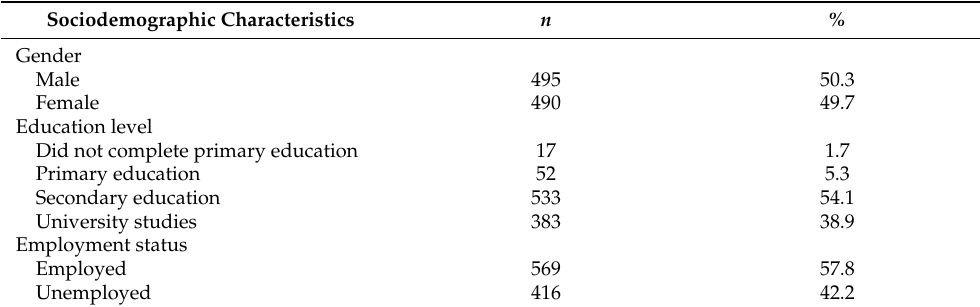
Table 1. Sociodemographic characteristics of participants.